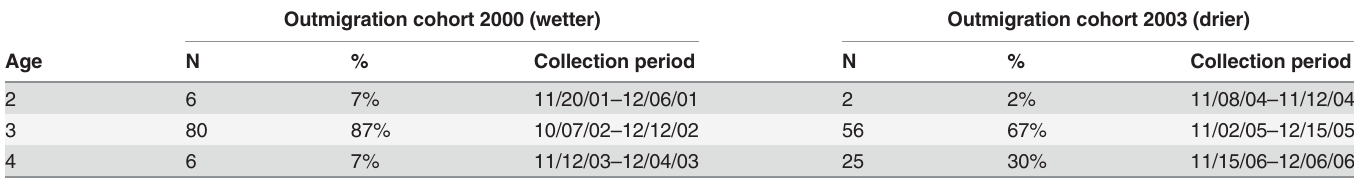
Table 1. Adult sample sizes, age structure and collection